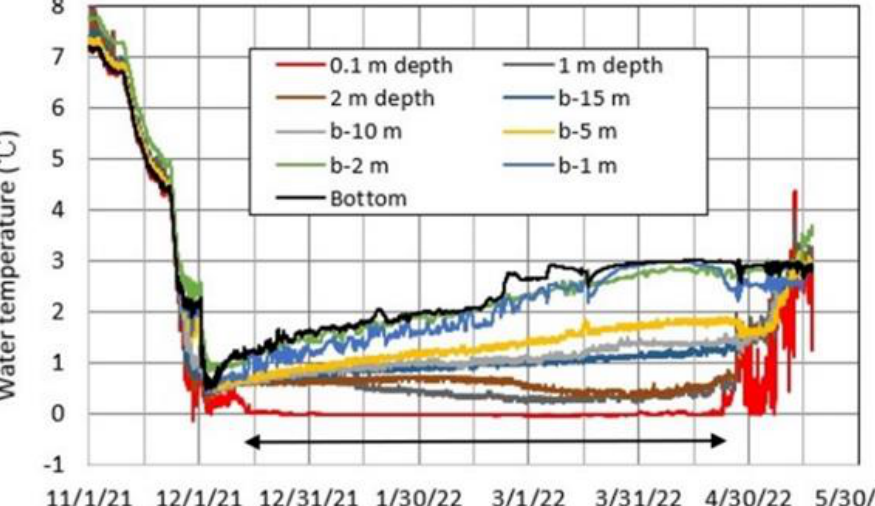
Figure 11. Temporal variations in hourly water temperature between the lake bottom and 0.1 m depth at site MD for 1 November 2021–17 May 2022. The labels, b-1 m, b-2 m, b-5 m, b-10 m, and b-15 m show water temperature at the heights of 1 m, 2 m, 5 m, 10 m, and 15 m above the bottom, respectively. The black arrow corresponds to the completely ice-covered period of 13 December 2021–23 April 2022, when the water temperature at 0.1 m depth is almost 0 ◦ C. For the completely ice-covered period of 3 December 2021–22 April 2022, water